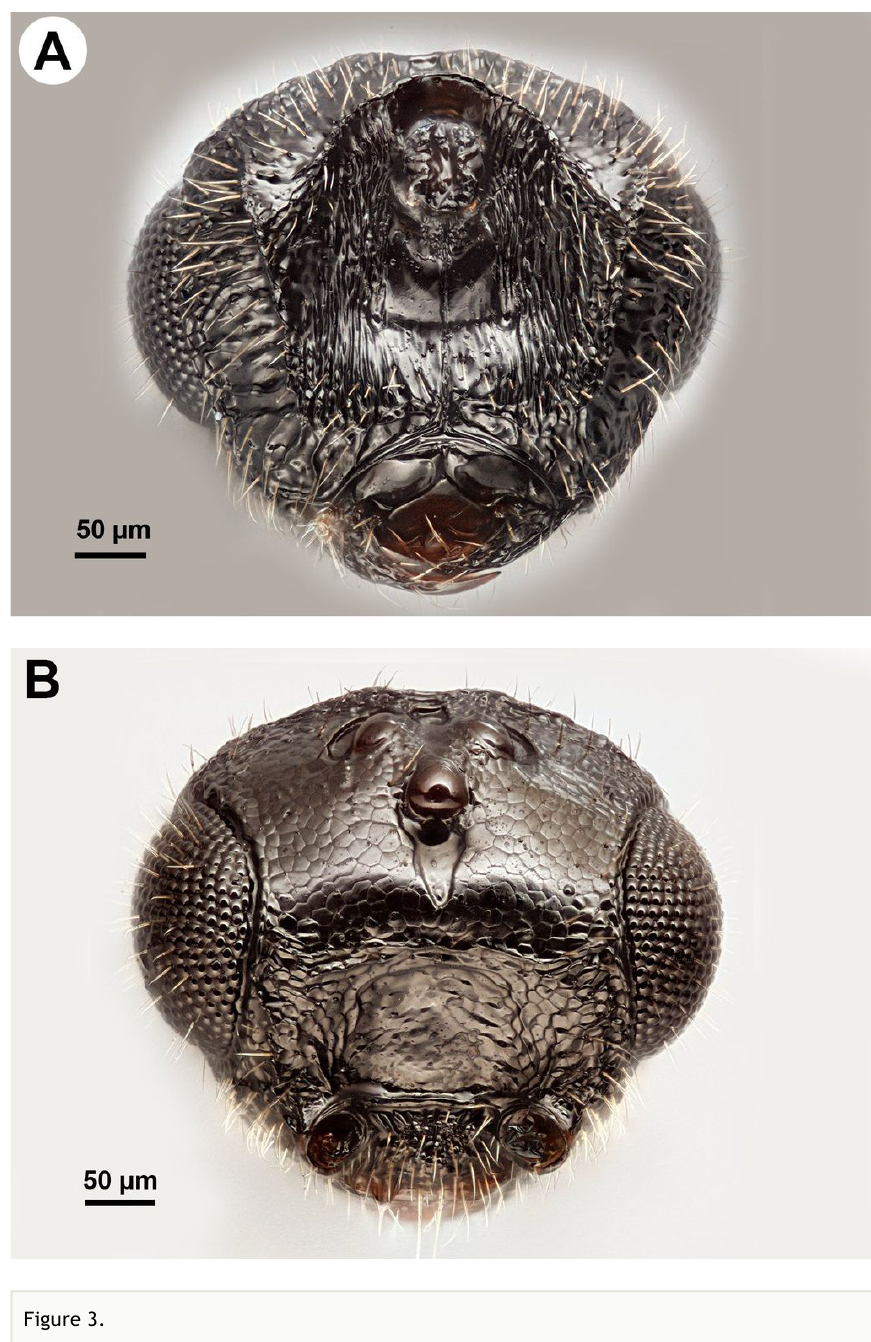
Bright fi eld images of male C. krogmanni head. a : Head in posterior view. b : Head in anterior